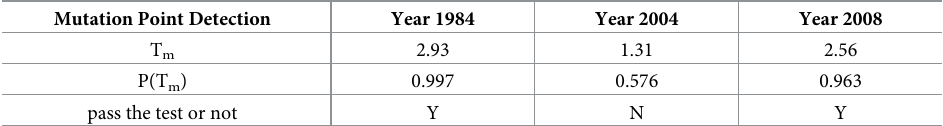
Table 2. Detection results of mutation year by B-G segmentation algorithm. Mutation Point Detection